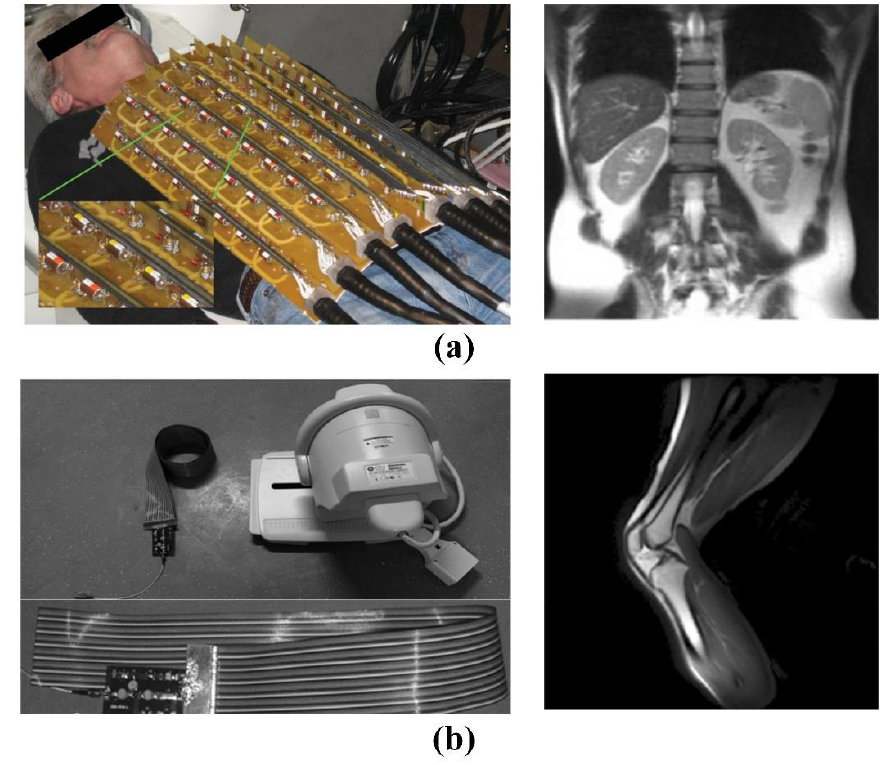
Figure 16. Conts